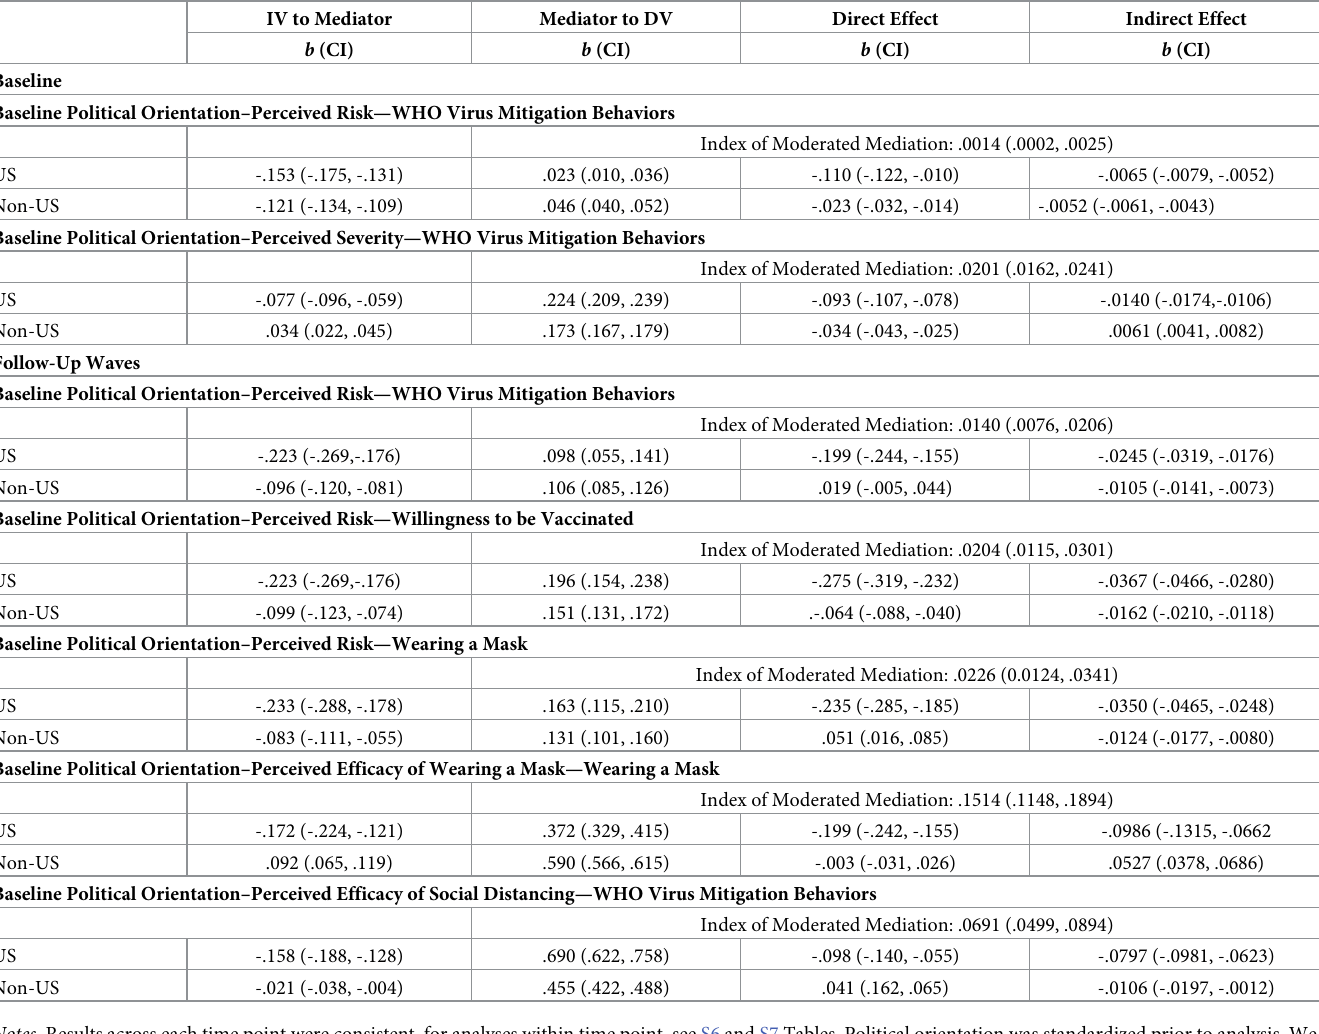
Table 6. Perceived risk and severity mediates the relationship between baseline political orientation and health-protective behaviors, Study